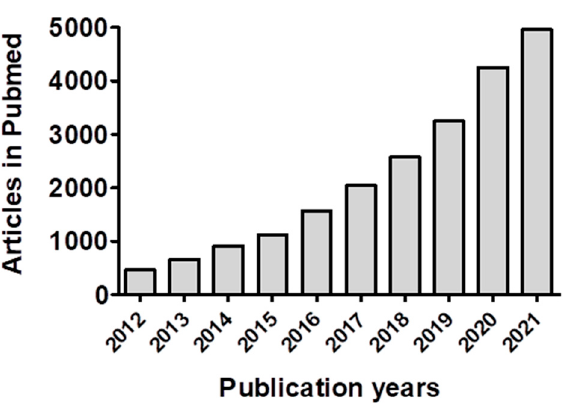
Figure 1. List of publications on exosomes in PubMed in last 10 years.